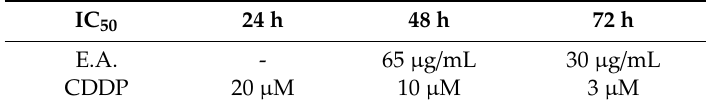
Table 2. IC 50 values determined from cell viability assays for E.A. and CDDP on the 4T1 breast cancer cells at the di ff erent times of treatment.